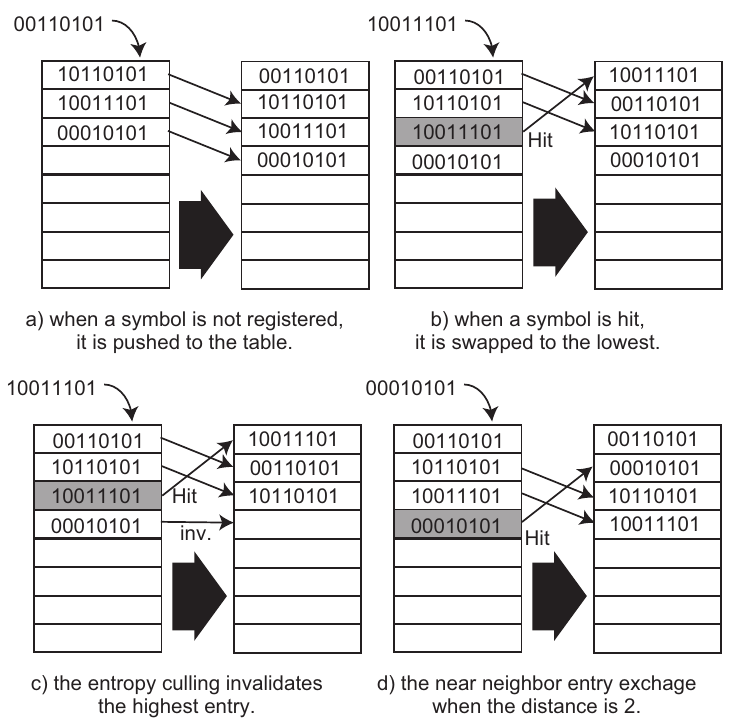
Figure 4. Look-up table operations in Adaptive Stream-based Entropy (ASE)